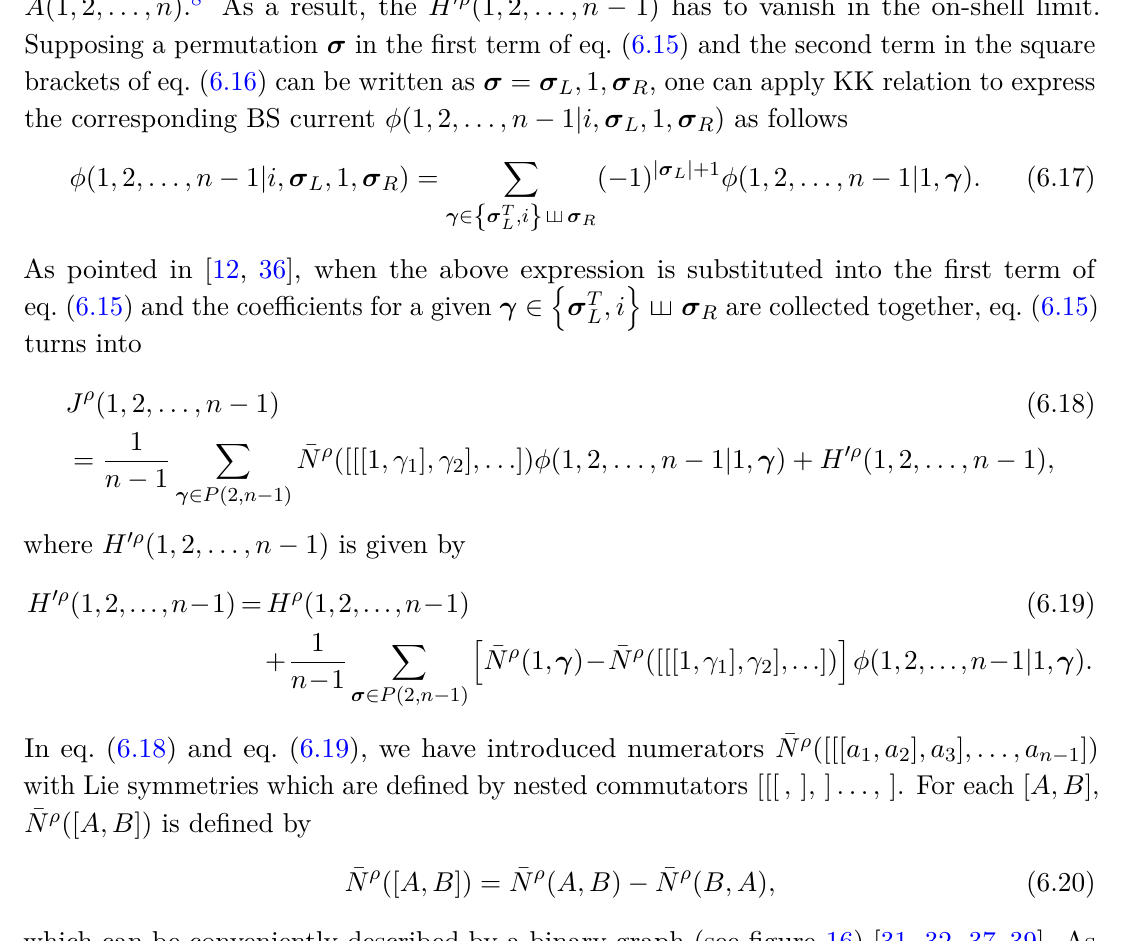
¯ N ρ ([ A, B ]) , where A and B